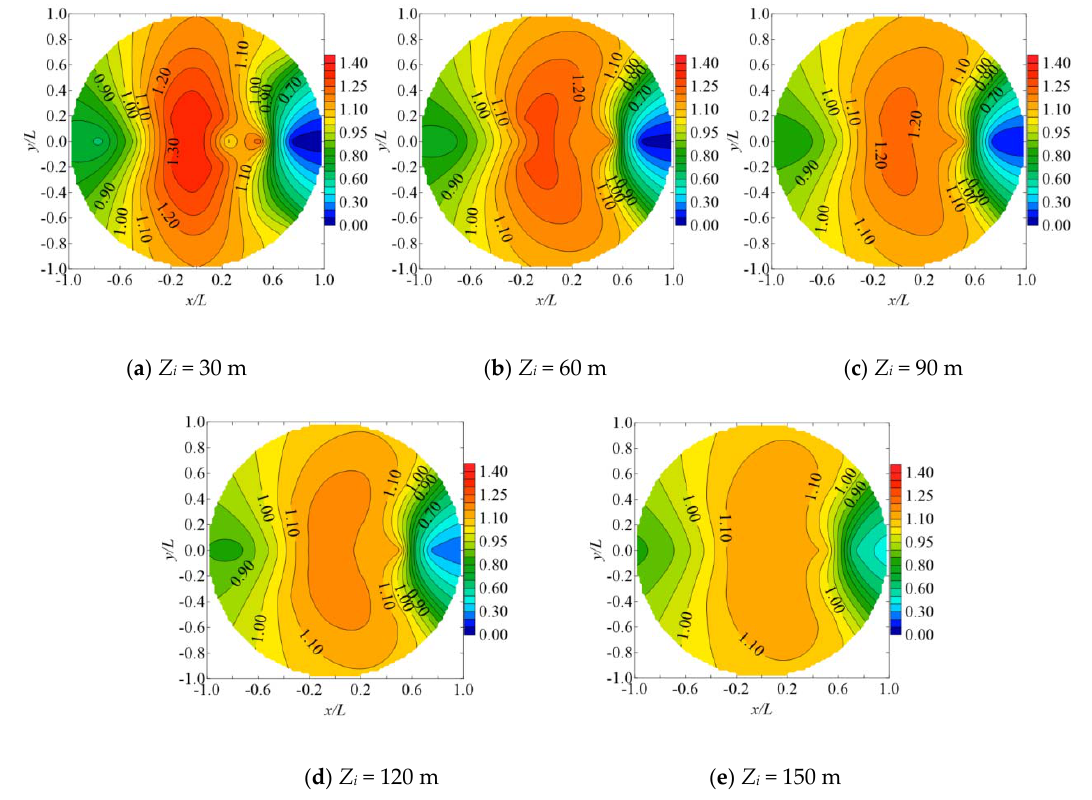
Figure 8. The wind speed ‐ up S u at different heights.